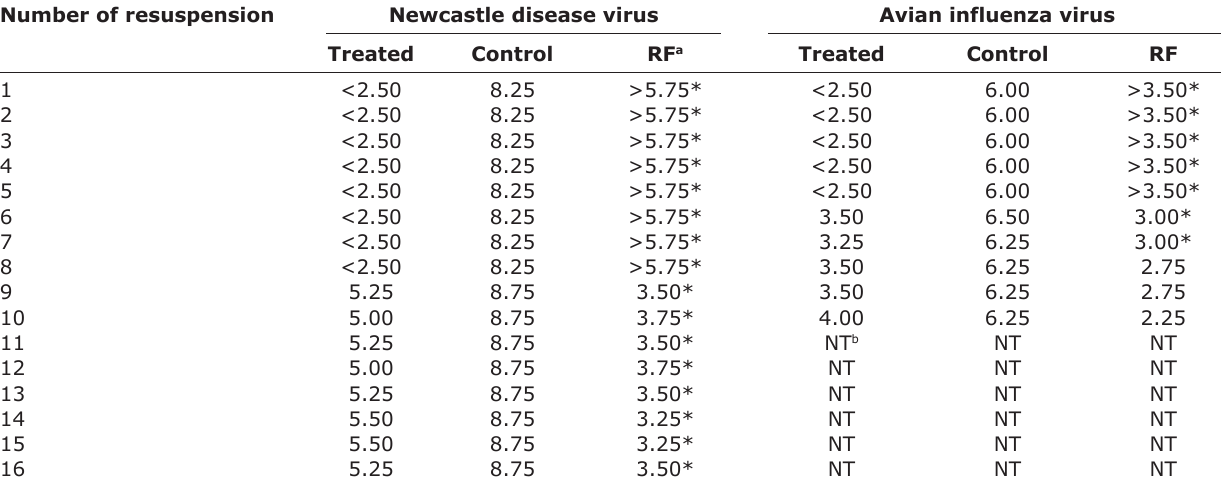
Table-4: Efficacy of food additive calcium grade hydroxide powder for inactivating Newcastle disease virus and avian influenza virus under wet and dry conditions at consecutive re-suspension times, with a 3-min incubation